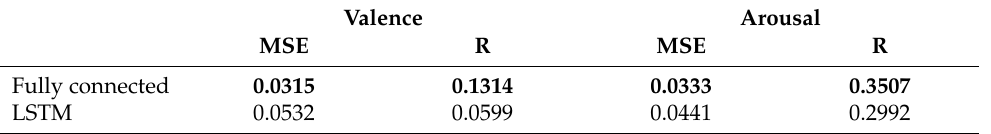
Table 5. Model performance when using only audio features as input. Best values in bold. Valence Arousal MSE R MSE R Fully connected 0.0315